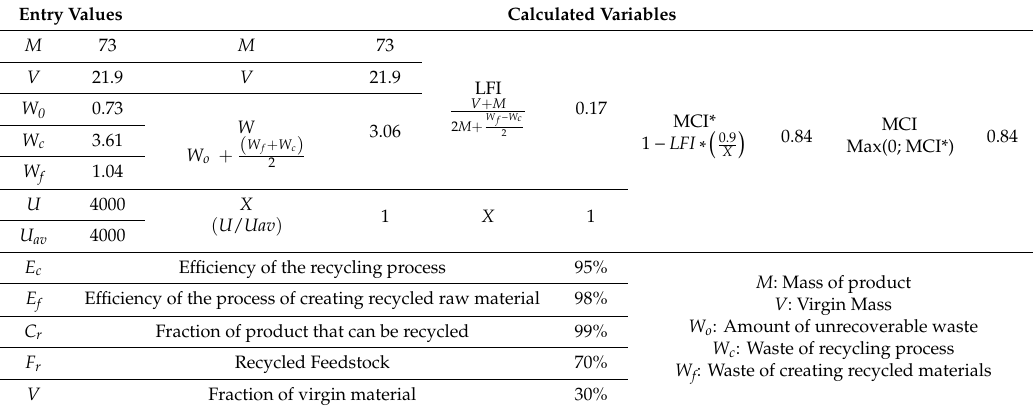
Table 1. Study of the circularity of a 3D part made with recycled PLA based on the EMF MCI